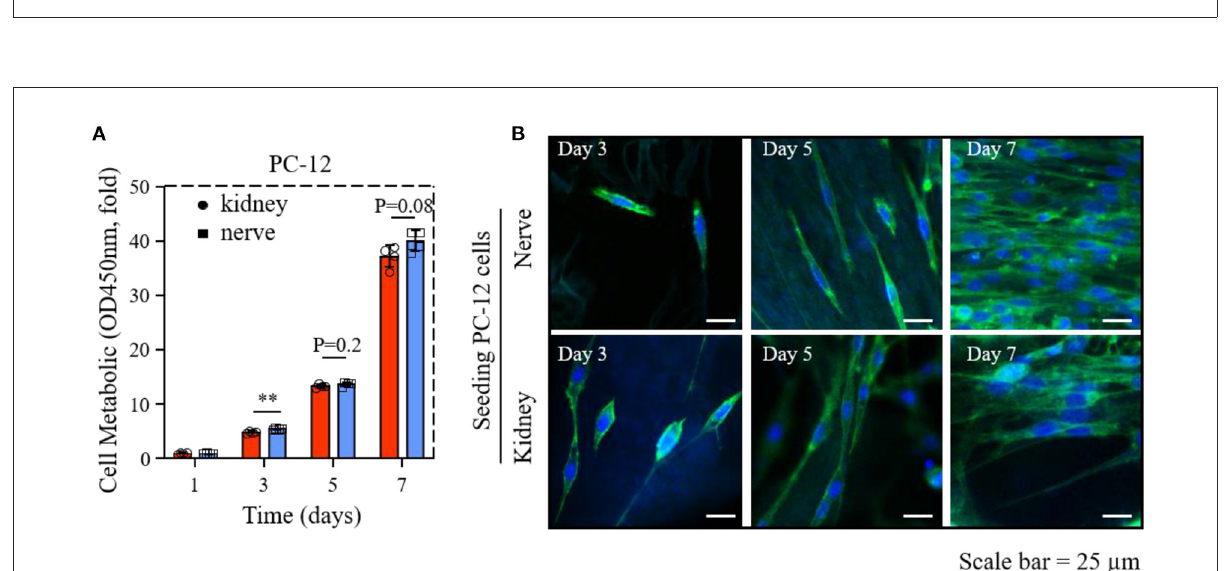
FIGURE4 The proliferation and morphology of PC-12 cells cultured on dK and dN; (A) The cck-8 result of PC-12 cells in 1, 3, 5, and 7 days; (B) images of PC12 cells stained with phalloidin (green) and nucleus (blue) after 3, 5, and 7 days of culture. ** P ≤ 0.01.